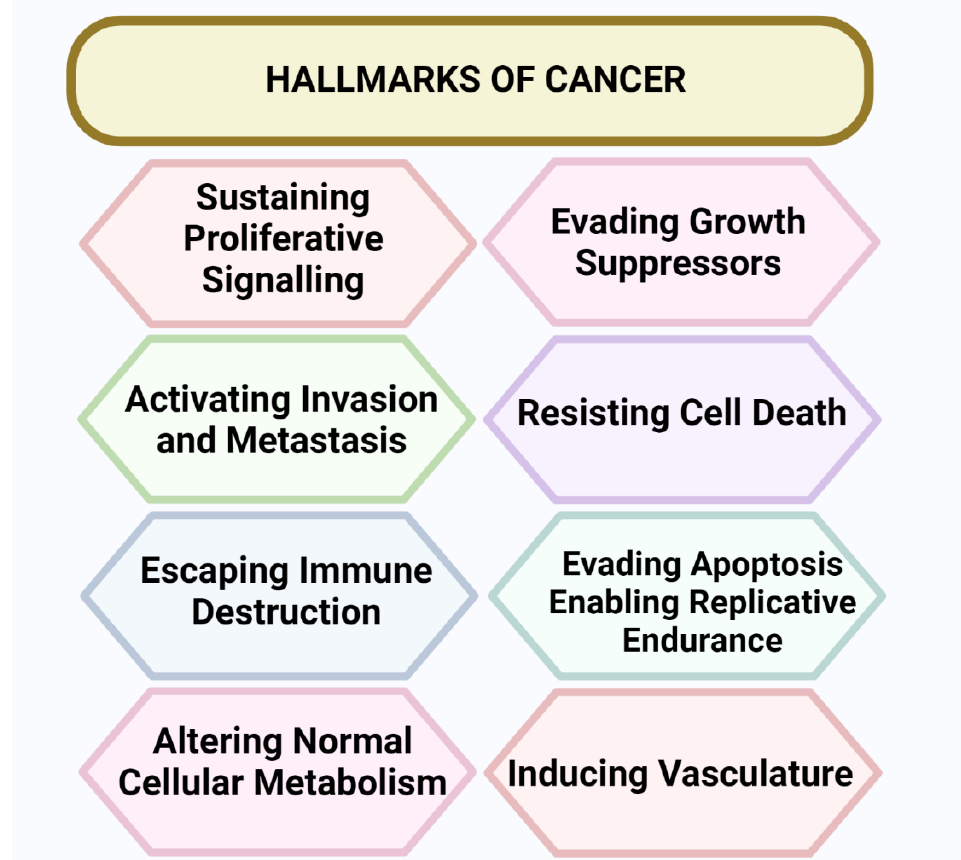
Figure 1. Hallmarks of cancer. There are eight hallmarks of cancer, including developing capabilities to sustain cell proliferative signaling, evading growth suppressors, activating invasion and metas- tasis, inducing angiogenesis, resisting cell death, enabling replicative immortality, reprogramming energy metabolism, and evading immune destruction.